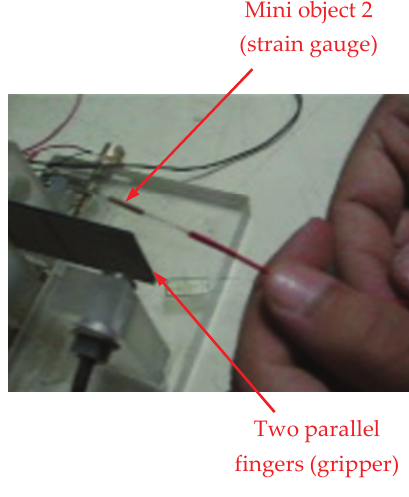
Figure 9. The developed micro-gripper carrying strain gauge